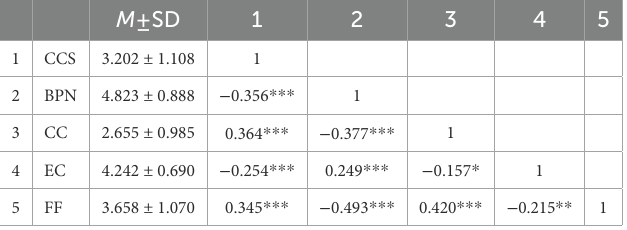
TABLE 3 Mean, standard deviation, and correlation matrix of the various variables ( n = 252).